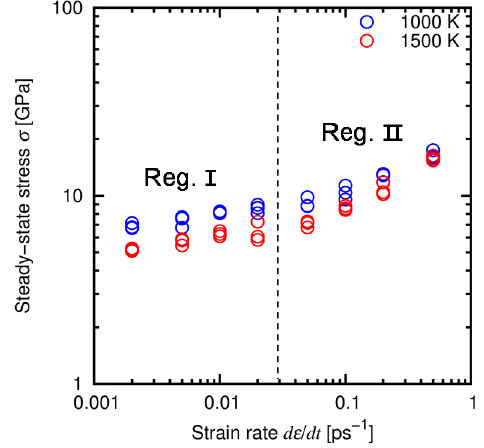
Figure 9. Atomic structure obtained at deformation test under the d ε / dt -constant condition at T = 1500 K and d ε / dt = 2 × Figure 9. Atomicstructureobtainedatdeformationtestunderthe d ε / dt -constantconditionat T =1500Kand d ε / dt = 2 × 10 − 3 ps − 1 ; Materials 2021 , 14 , x FOR PEER REVIEW 10 − 3 ps − 1 ; ( a ) ε = 0.0 (before deformation), ( b ) ε = 0.5 (after deformation). ( a ) ε = 0.0 (before deformation), ( b ) ε = 0.5 (after deformation).